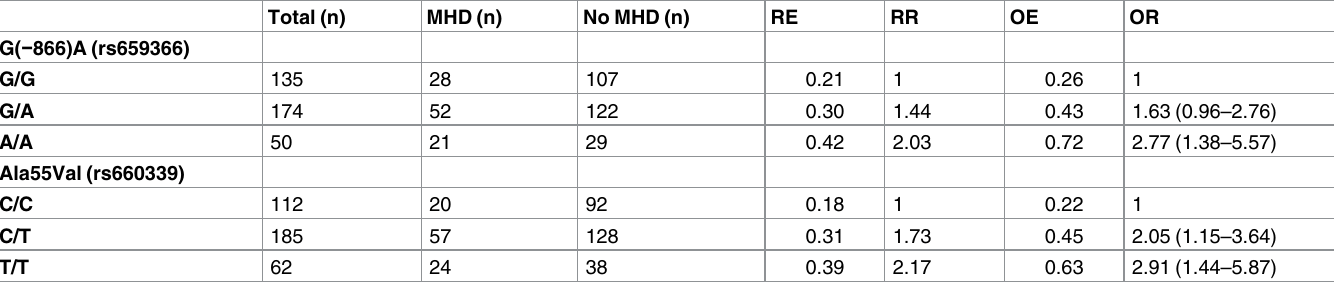
Table 2. Comparisons of risk and odds between the genotypes in men.